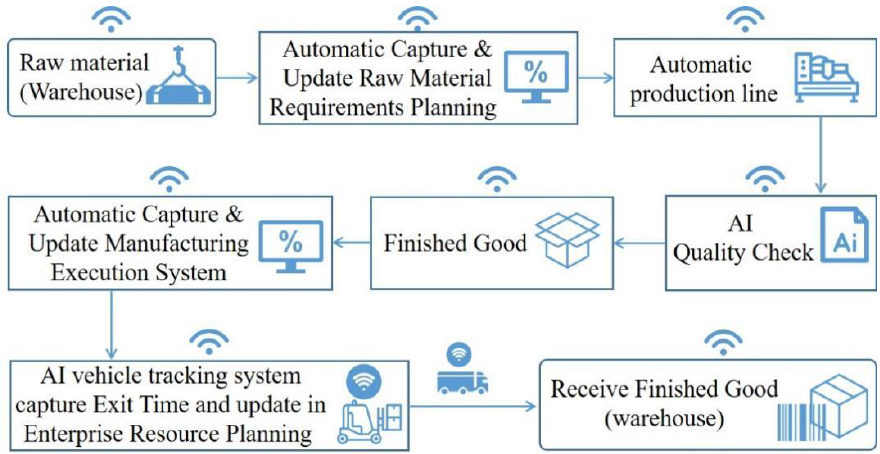
Figure 1. The smart-factory production process aided by wireless networks.